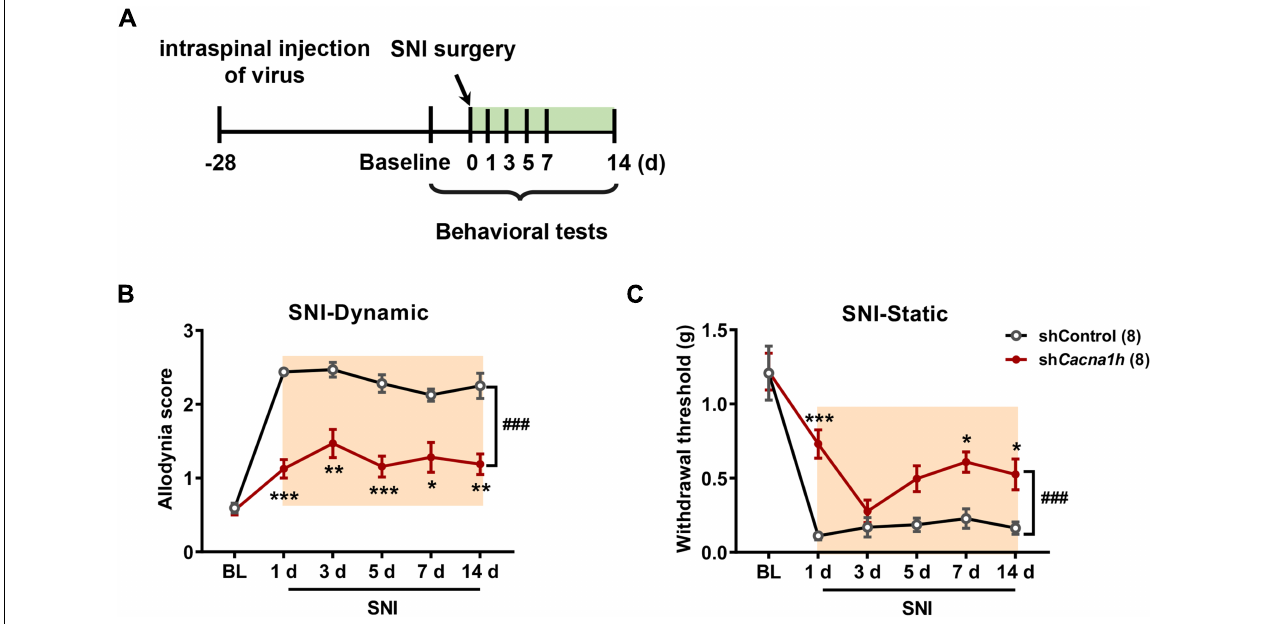
FIGURE 6 | Knockdown of Cacna1h in spinal SOM + neurons attenuated dynamic and static allodynia in an SNI-induced neuropathic pain model in mice. (A) Schematic illustration of the timeline of virus injection, model establishment and behavioral tests. Non-silence shRNA virus was used as a control. (B,C) Both the dynamic allodynia score (B) and the static allodynia reflected as the 50% withdrawal threshold (C) were reduced by Cacna1h knockdown in spinal SOM + neurons in the SNI model. ### P < 0.001, two-way ANOVA with Sidak post hoc analysis. * P < 0.05, ** P < 0.01, *** P < 0.001, difference between the two groups at the corresponding time points. BL,